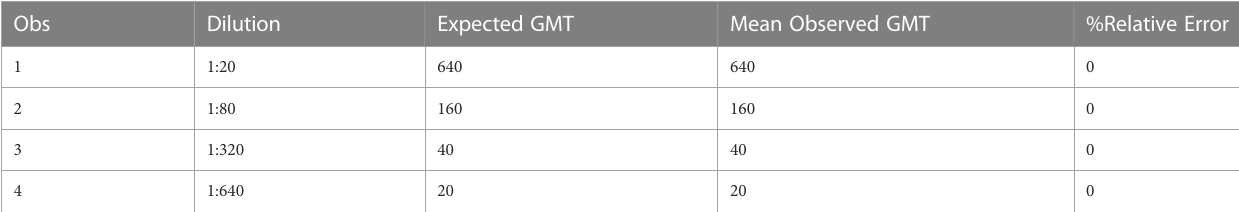
TABLE 4 HAI assay quali fi cation on H3N2 in fl uenza strain A/Texas/71/2017, accuracy testing, % RE results.